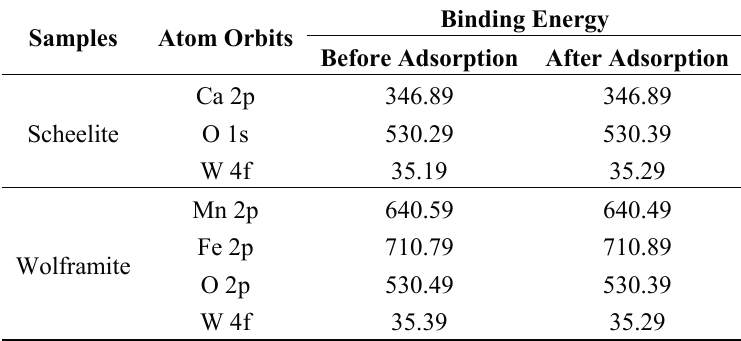
Table 2. Binding energy of atom orbits on mineral surfaces before and after adding lead nitrate.